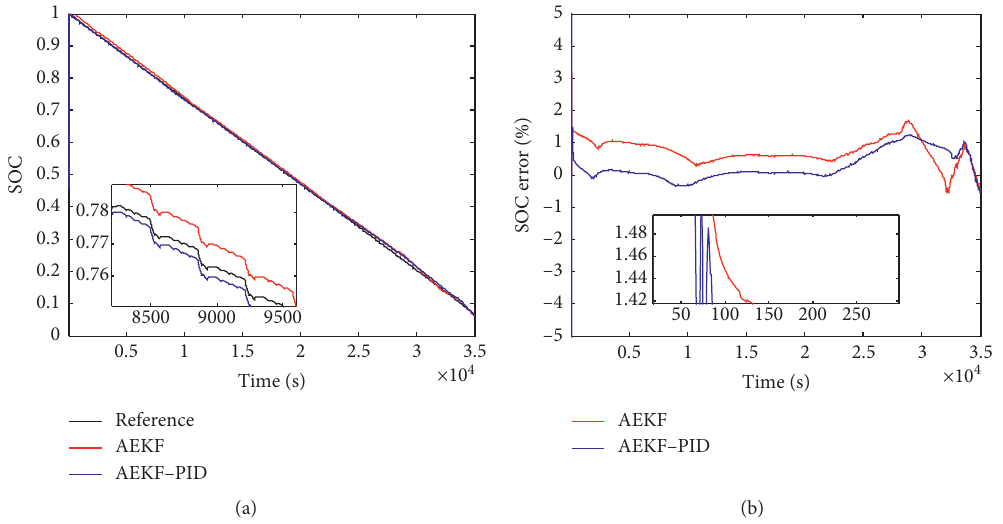
Figure 11: Comparison of SOC estimation under DST: (a) SOC estimation result; (b) SOC estimation